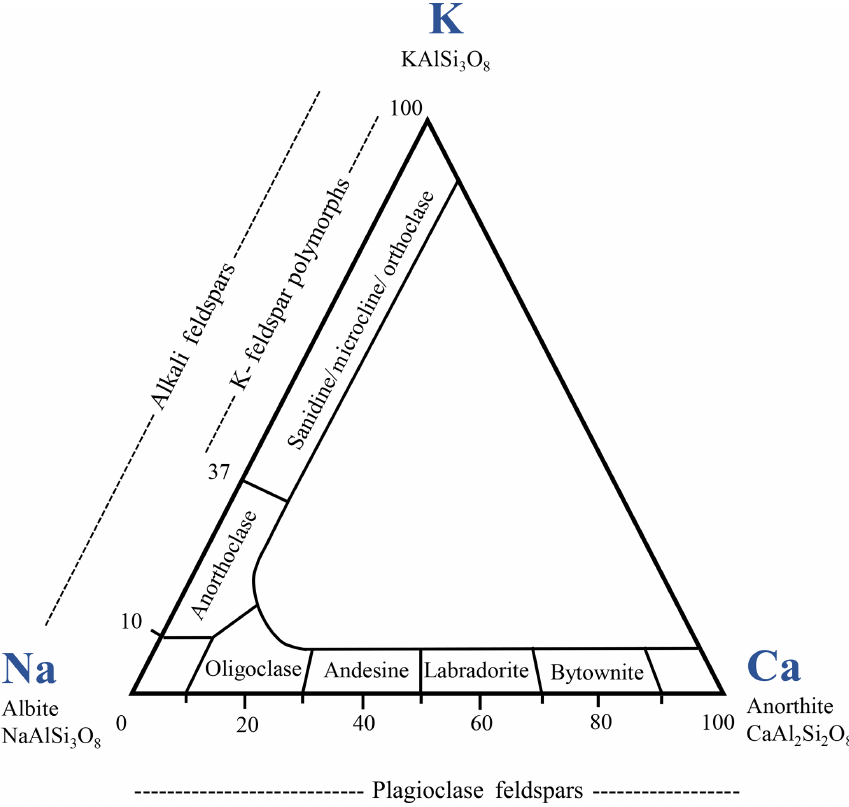
Figure 1. Feldspar classification diagram. Numbers are contributions of the end-member minerals in wt% (adapted from Greenwood and Earnshaw,